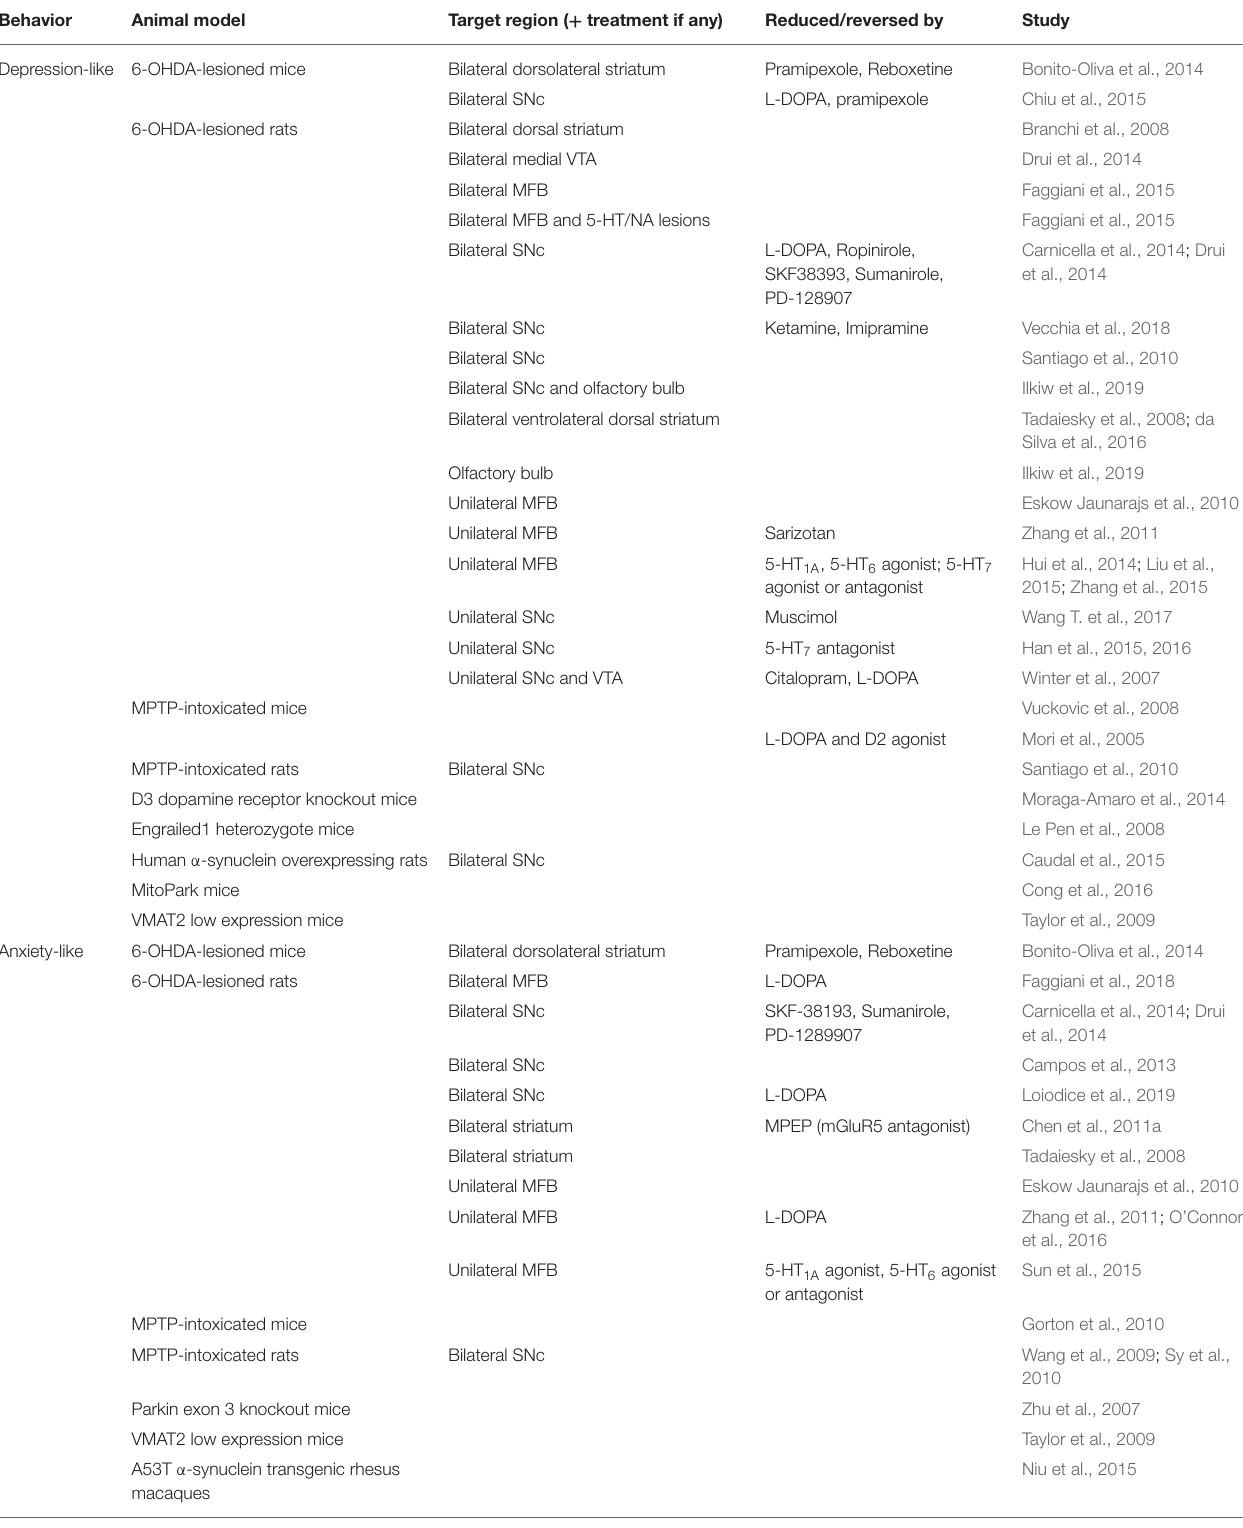
TABLE 1 | Summary of the preclinical studies investigating the pathophysiology of PD-related neuropsychiatric-like